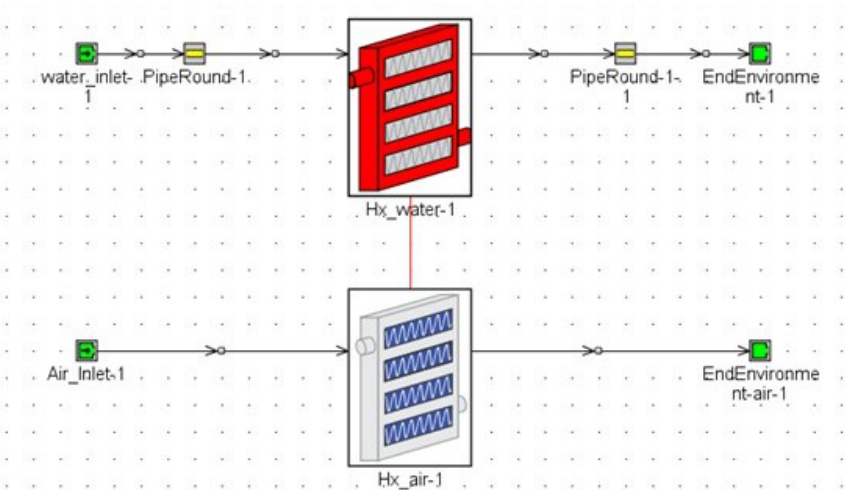
Figure 6. Heater core modeling diagram.